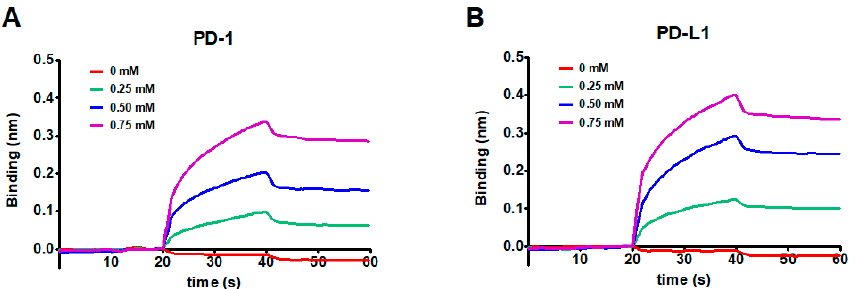
Figure 4. Global kinetic analysis of KR binding to biotinylated PD-1 ( A ) and PD-L1 ( B ) immobilized on a streptavidin biolayer interferometry (BLI) sensor. The binding of test inhibitors with PD-1 was confirmed by BLI analysis. The kinetics of KR for immobilized PD-1 and PD-L1 were monitored with increasing concentrations of KR (0, 0.25, 0.5, and 0.75 mM) dissolved in phosphate-bu ff ered saline (PBS) bu ff er (pH 7.3) containing 1% DMSO. Data are presented as representative of three independent experiments.